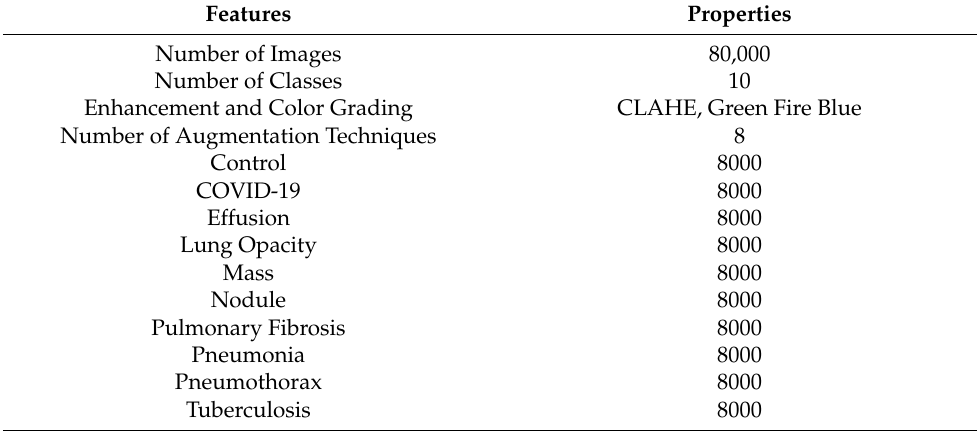
Table 5. The final dataset after pre-processing.